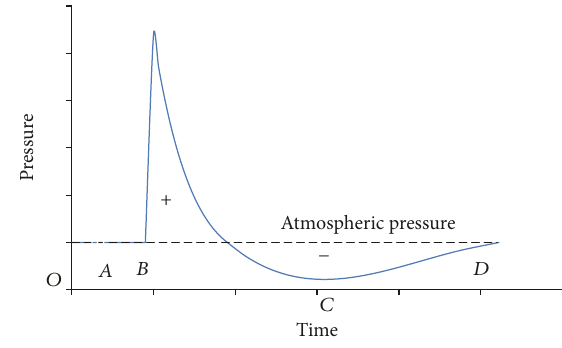
Figure 1: Pressure-time diagram of blast